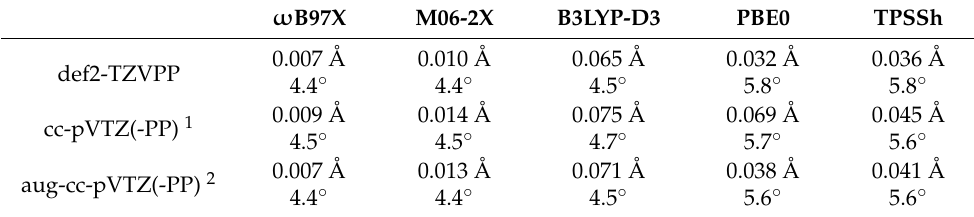
Table 3. Root-mean-square deviation (RMSD) values for DFT structures calculated with various combinations of functionals and basis sets. RMSD values are with respect to the experimental structural parameters determined from GFA of TRXL data. Among tested functionals, the ω B97X functional had the best agreement with the experimental values, regardless of basis